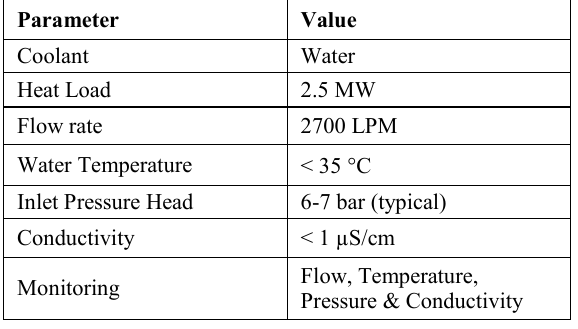
Fig. 18: General I&C configuration for the IIGTF Cooling distribution system